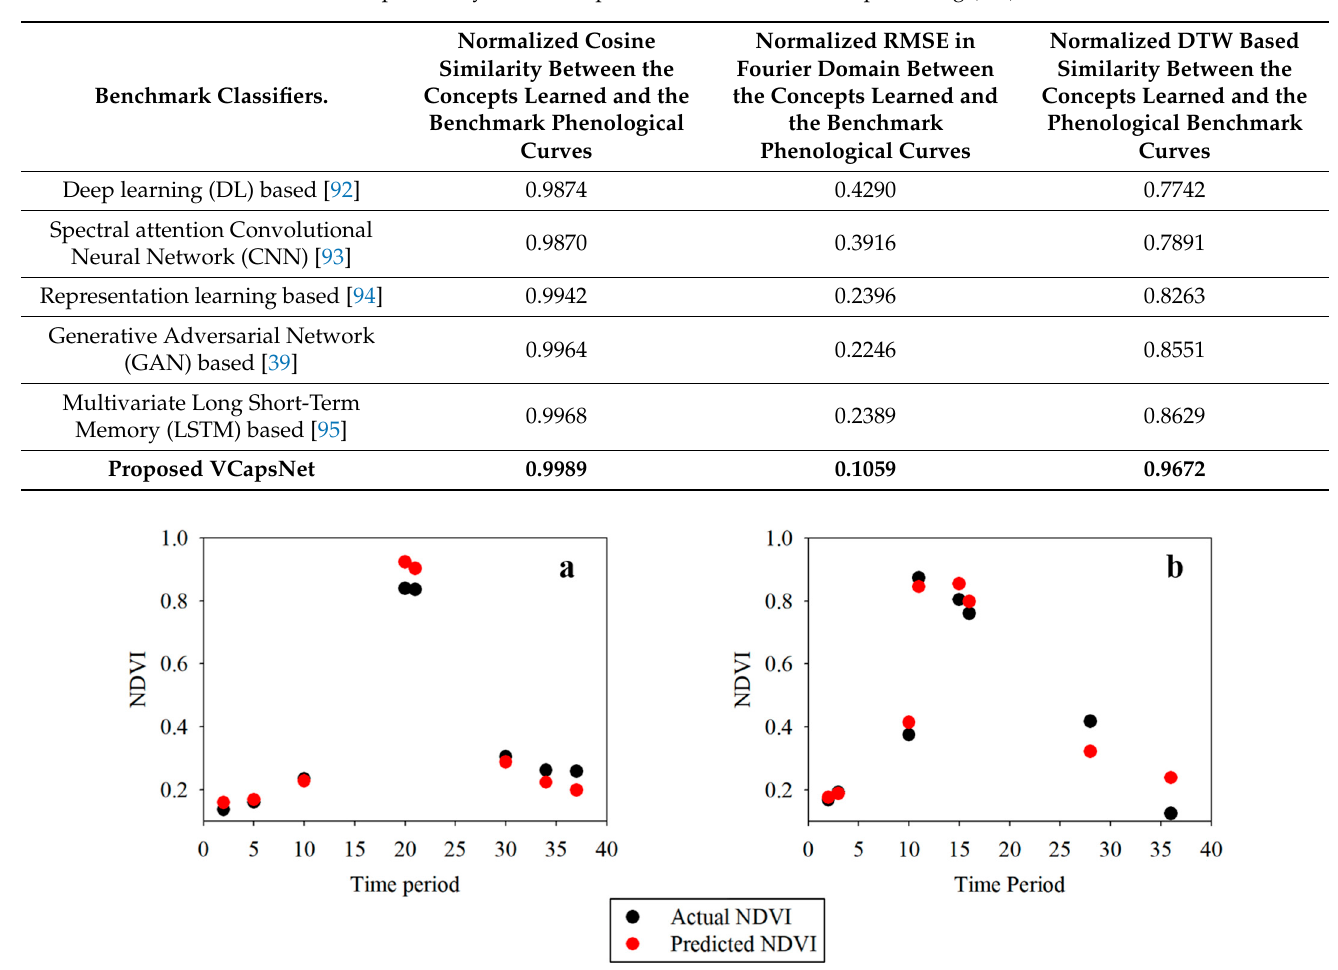
Figure 8. Expected and predicted NDVI corresponding to wheat ( a ) and barley fields ( b